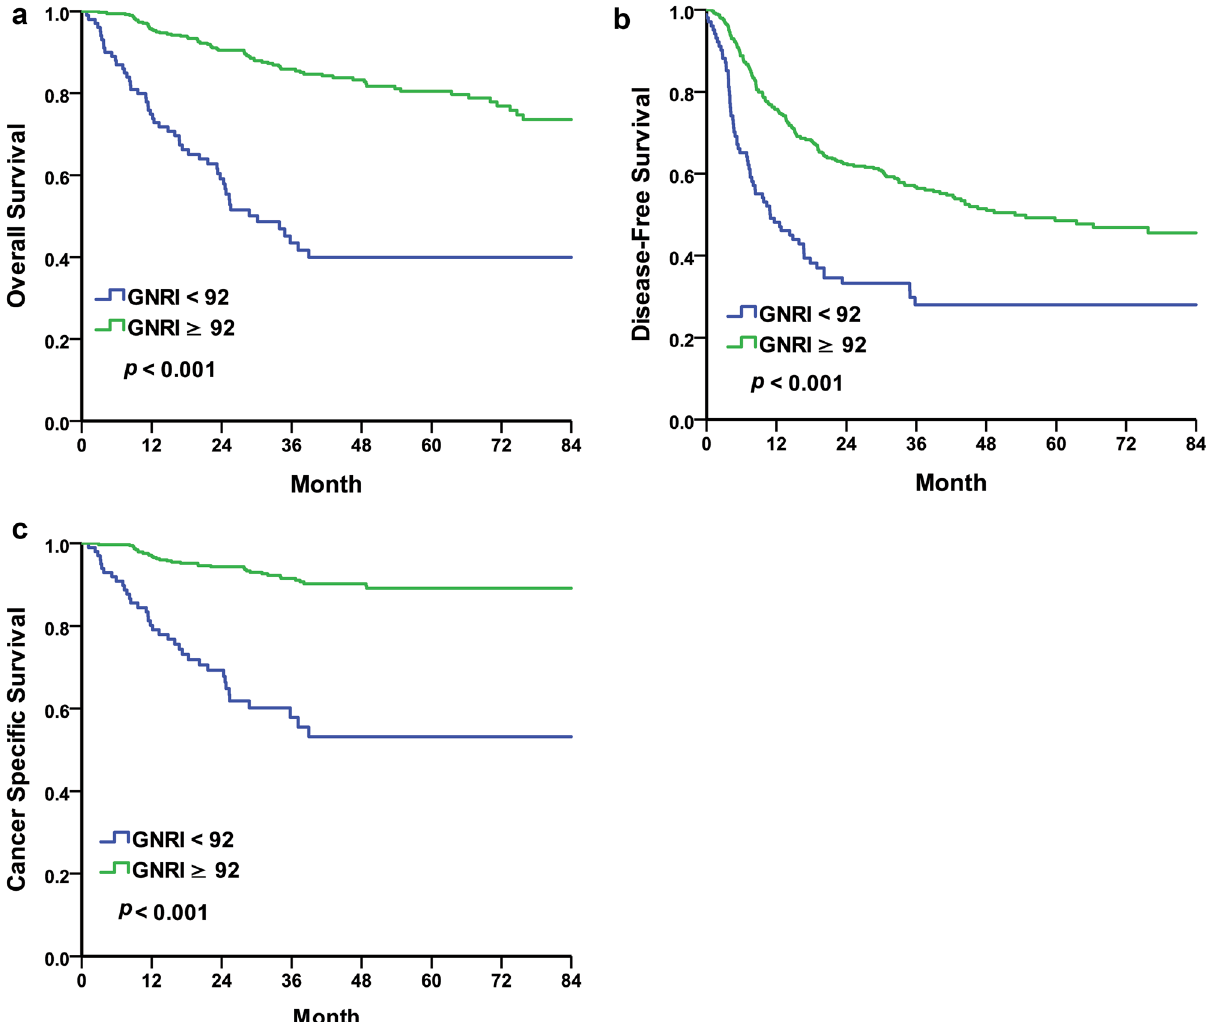
Figure 2. Kaplan–Meier curve for UTUC patients comparing normal nutrition group and malnutrition group according to GNRI = 92. ( a ) Overall survival, median 30.16 months in malnutrition group and half of patients were survive in normal nutrition group, p < 0.001. ( b ) Disease free survival, median 10.97 months in malnutrition group and 52.93 months in normal nutrition group, p < 0.001. ( c ) Cancer specific survival, median time were not calculated due to half of patients were survive in both group, p <